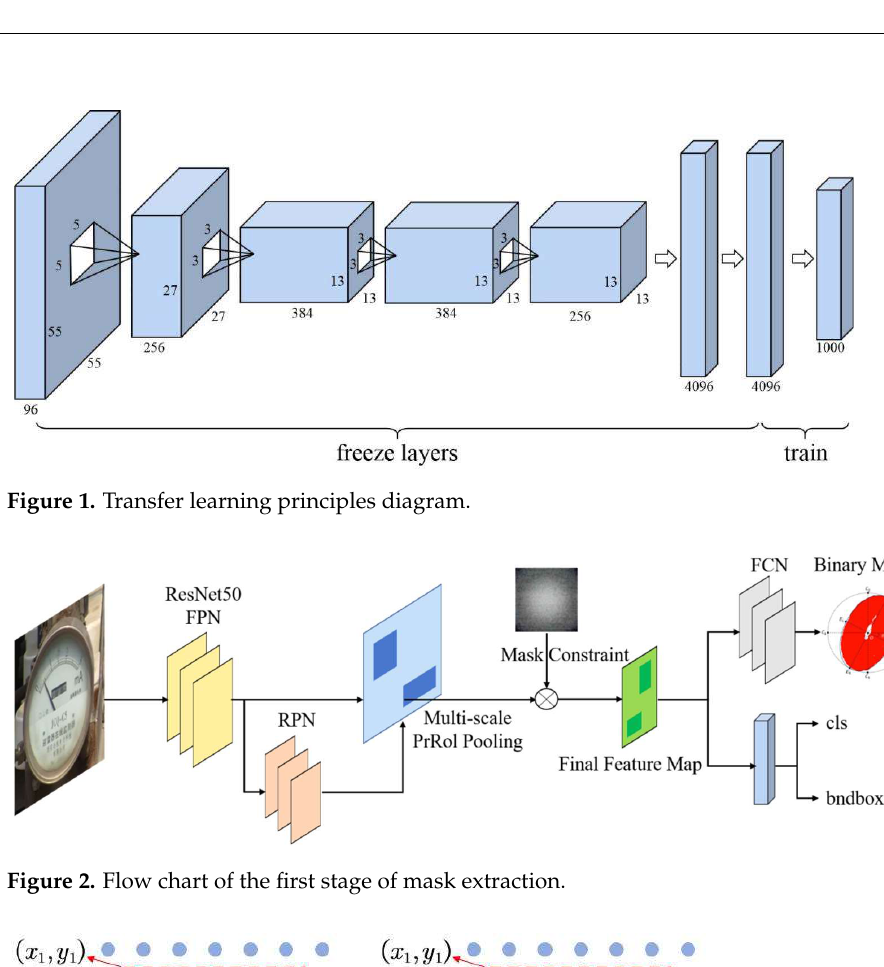
Figure 2. Flow chart of the first stage of mask extraction.